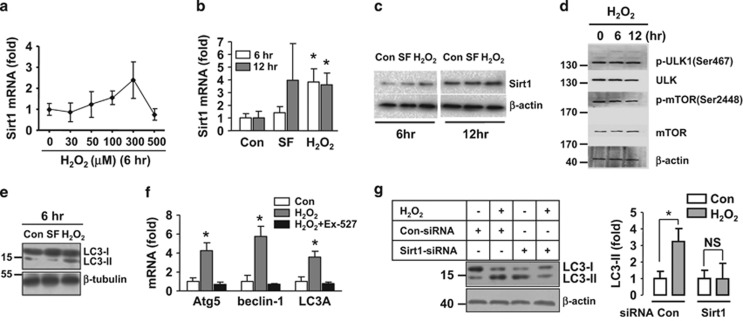
Sirt1 was a redox-sensitive regulator of reactive oxygen-induced autophagy. (a) Concentration-dependent effects of exogenous H2O2 on the expression level of Sirt1. (b) Effects of H2O2 (300 μM) on Sirt1 mRNA expression at 6 and 12 h. Serum-free treatment was used as a control. (c) Effects of H2O2 and serum free on Sirt1 protein expression. (d) Effects of H2O2 on phosphorylation of mTOR and ULK1. (e) Effects of H2O2 and serum-free treatment on the protein level of LC3. (f) H2O2 increased the expression levels of Atg5, beclin-1, and LC3A, which were blocked by pretreatment with EX-527 (10 μM). (g) Western blot and quantitative densitometry data showing the effects of control and Sirt1 siRNA on the autophagic response induced by H2O2 (300 μM). Data are mean±S.E.M. *P<0.05, one-way analysis of variance, n=3–4. The western blots were representative examples from three experiments. NS, no significance; SF, serum free